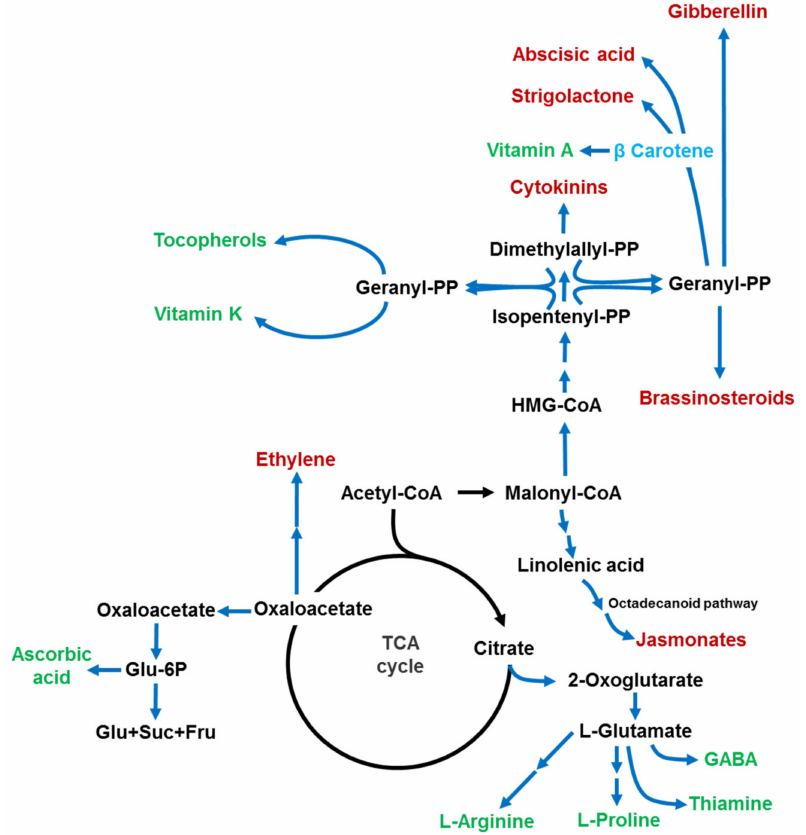
Figure 4. Schematic representation of CA metabolism in plants. Citrate derived from the TCA cycle can be converted to acetyl-CoA. Acetyl-CoA carboxylase converts acetyl-CoA to malonyl-CoA, a precursor for fatty acid and jasmonate biosynthesis via the octadecanoid metabolic pathway. Malonyl Co-A also feeds into the mevalonate pathway and provides building blocks of phytohormones (cytokinins, gibberellins, abscisic acid, brassinosteroids, and strigolactones) and vitamins (vitamin K and vitamin A). Oxaloacetate (OAA) can be converted into glucose-6-phosphate via PEP caroxykinase and phosphatases, providing a source of ascorbic acid as well as glucose, sucrose and fructose. 2-oxoglutarate can be converted into glutamate, feeding into GABA and amino acid biosynthesis.